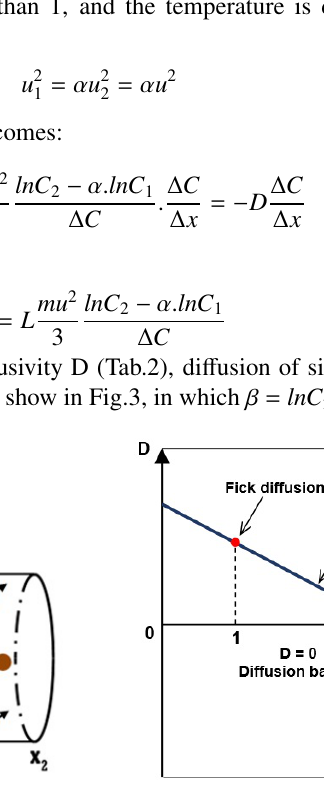
Figure 3. Classified di ff usion in single